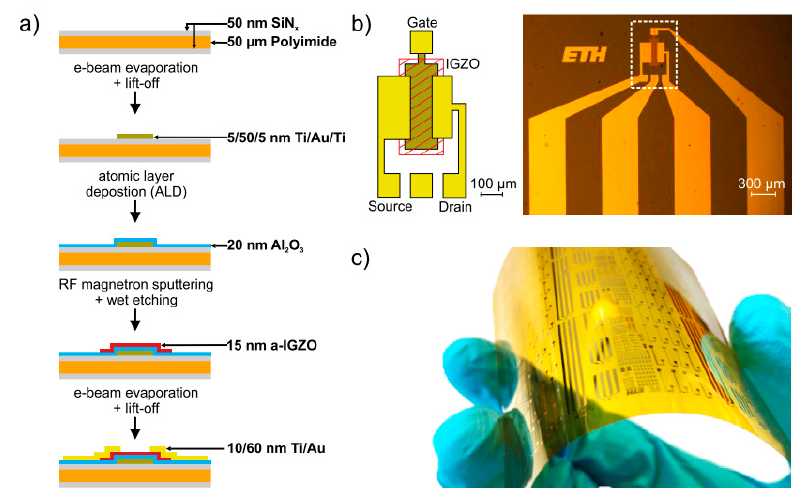
Figure 10. ( a ) schematic fabrication flow of the gas sensitive TFT, ( b ) layout of the TFT, ( c ) photograph of the fabricated sensors on the flexible polyimide substrate [172].